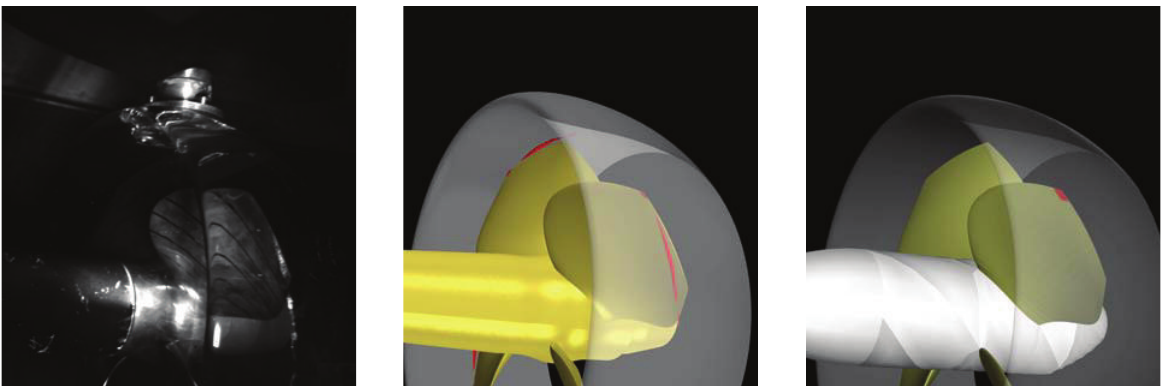
Figure 15: Observed and predicted (RANS and panel method) cavity extension. Design thrust coe ffi cient at 135% of design cavitation